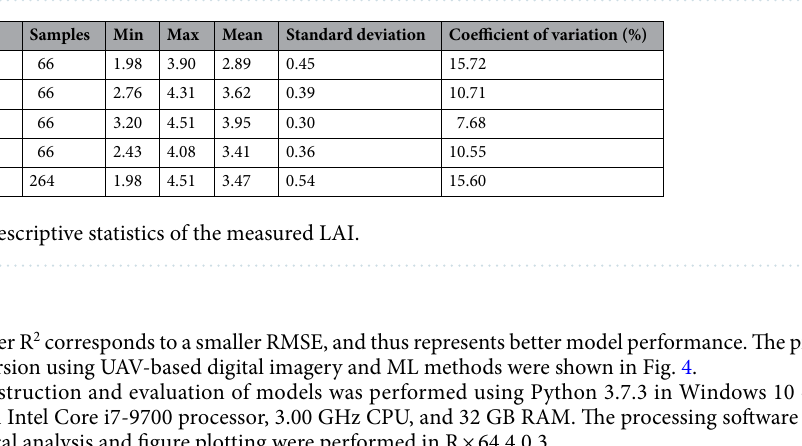
Figure 4. Flowchart of LAI inversion using UAV-based remote sensing and ML methods.